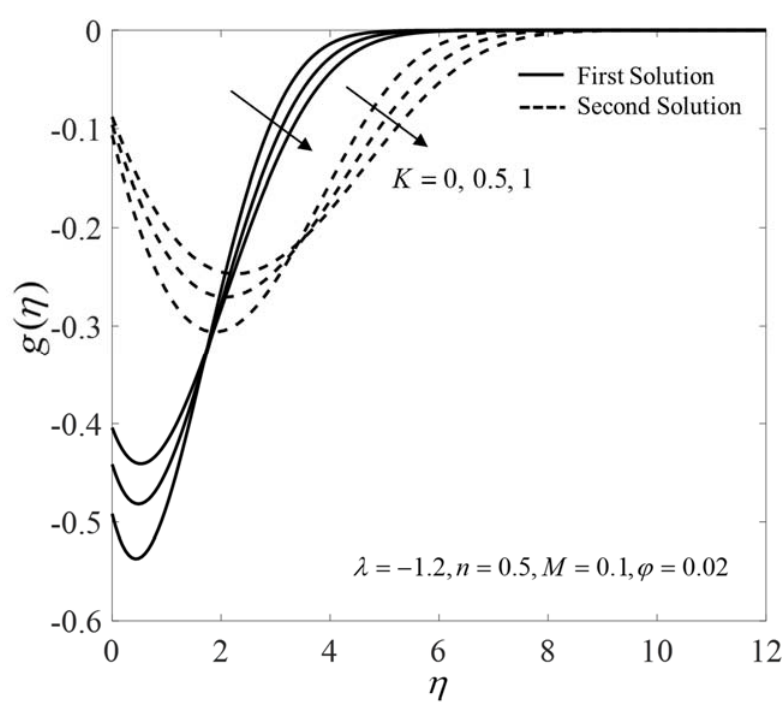
Figure 9. The plot of 𝑔(cid:4666)𝜂(cid:4667) for various 𝐾 values.